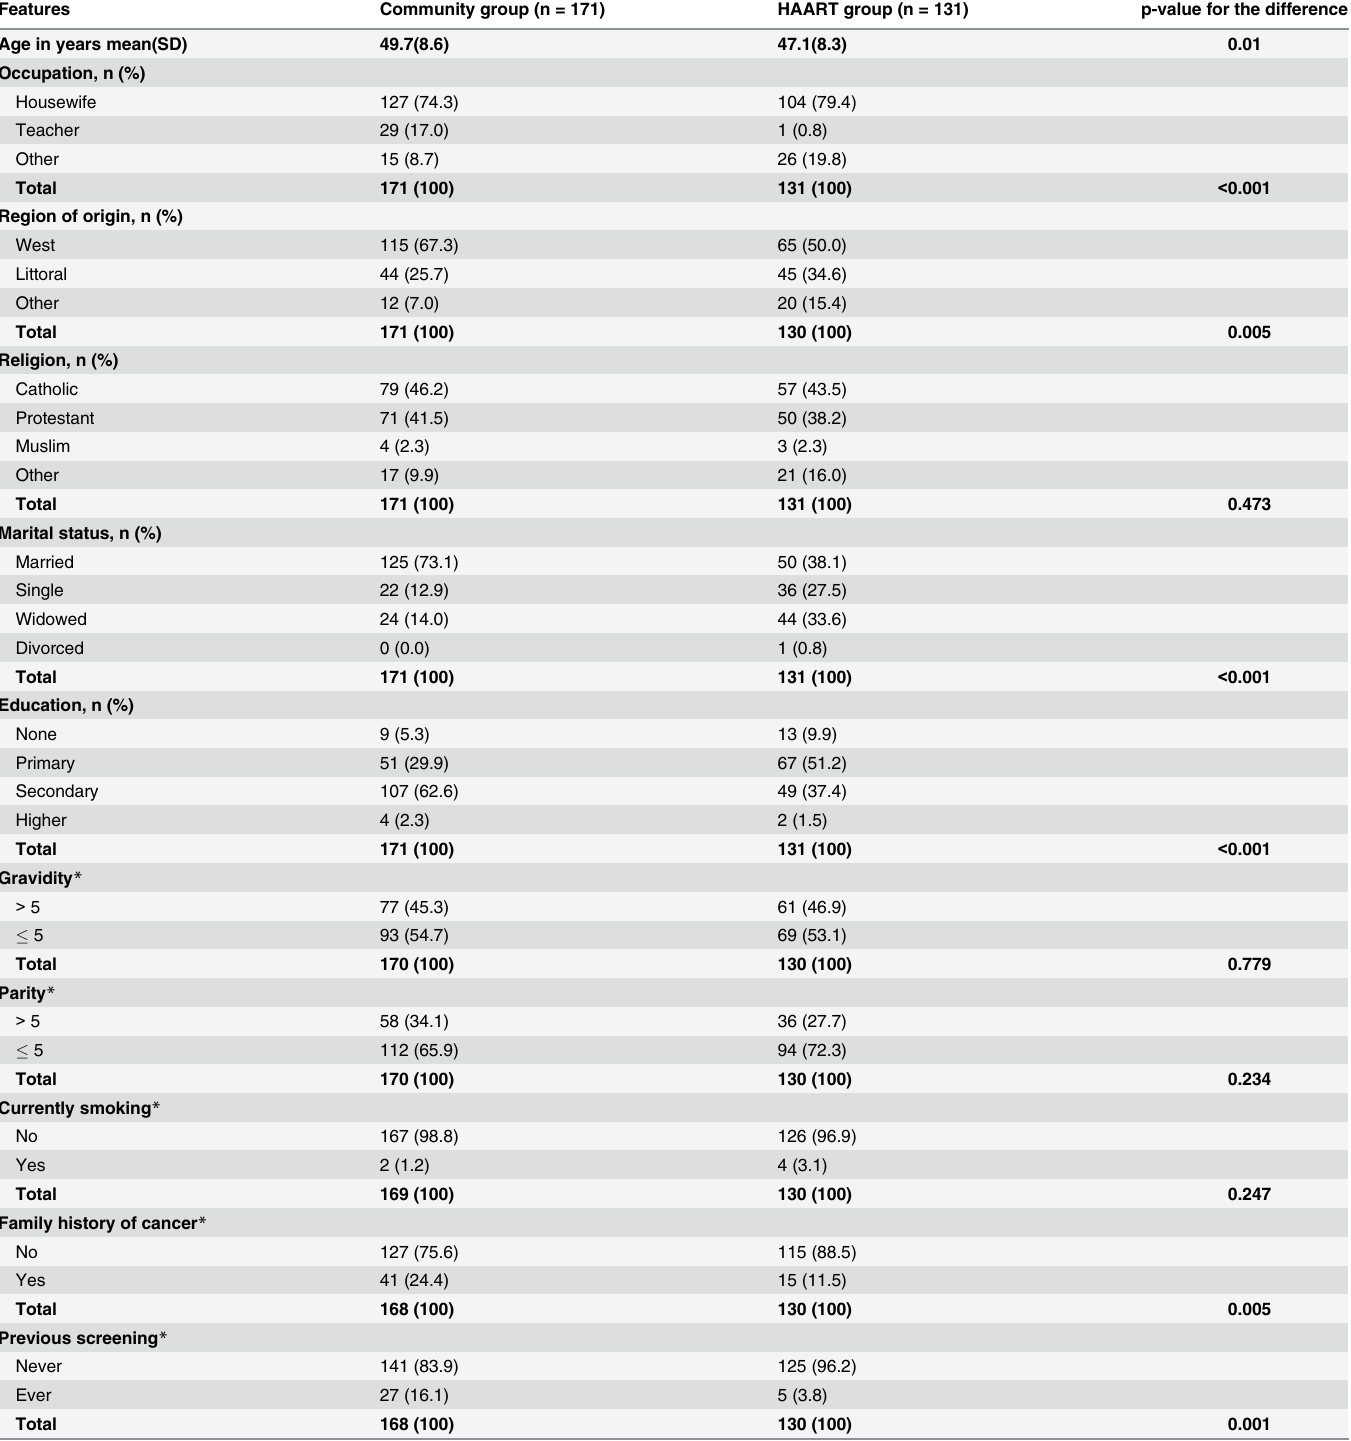
Table 1. Comparison of baseline characteristics of the study